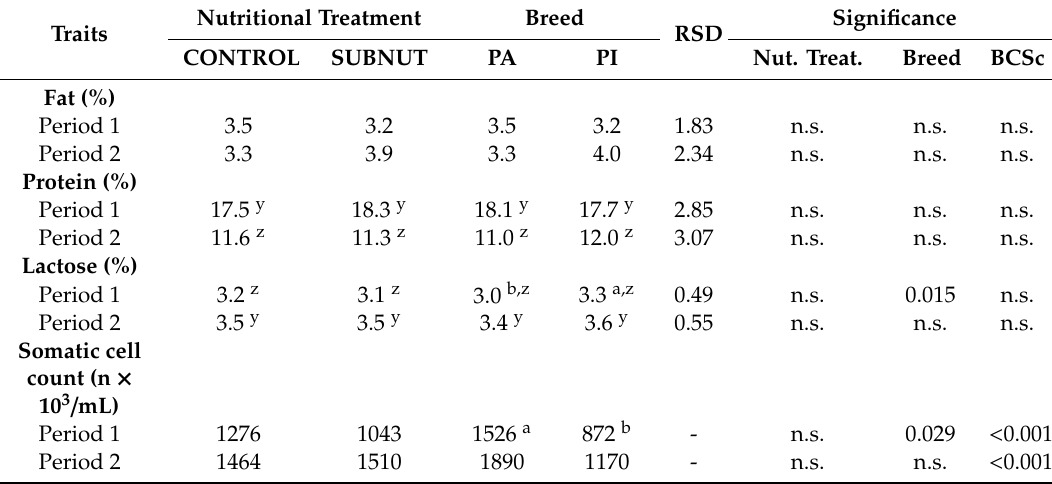
Table 5. Colostrum composition, according to the nutritional treatment and the breed (cow BCS at calving included as a covariate).